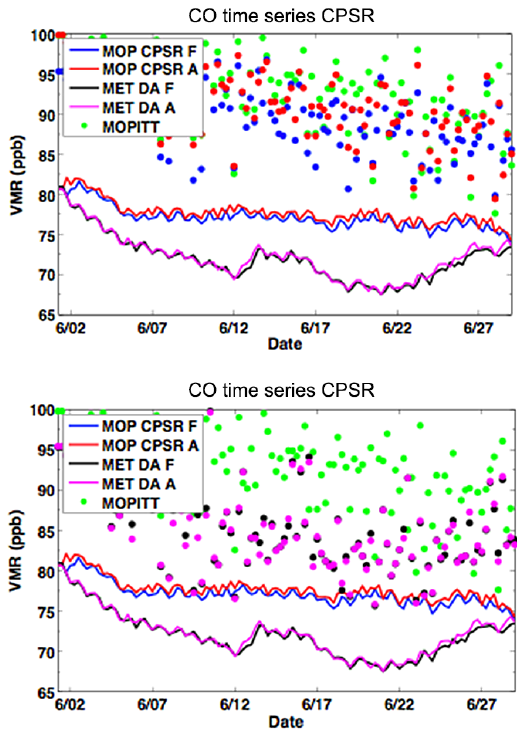
Figure 6. Same as Fig. 2 except for the MOP CPSR experiment.